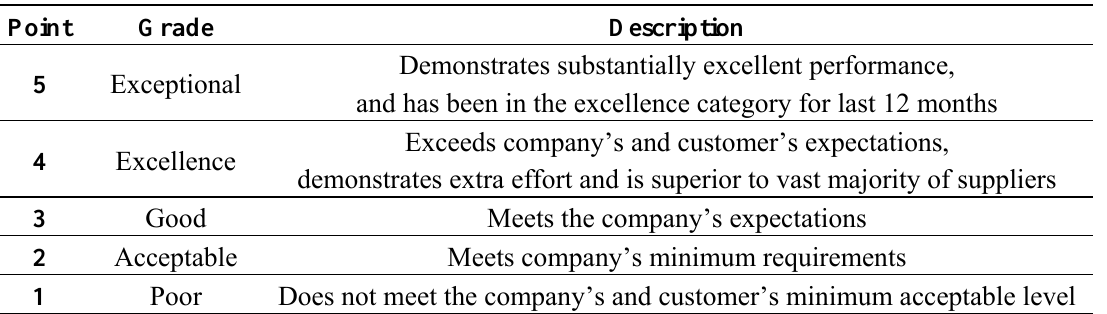
Table 2. Guideline for supplier rates